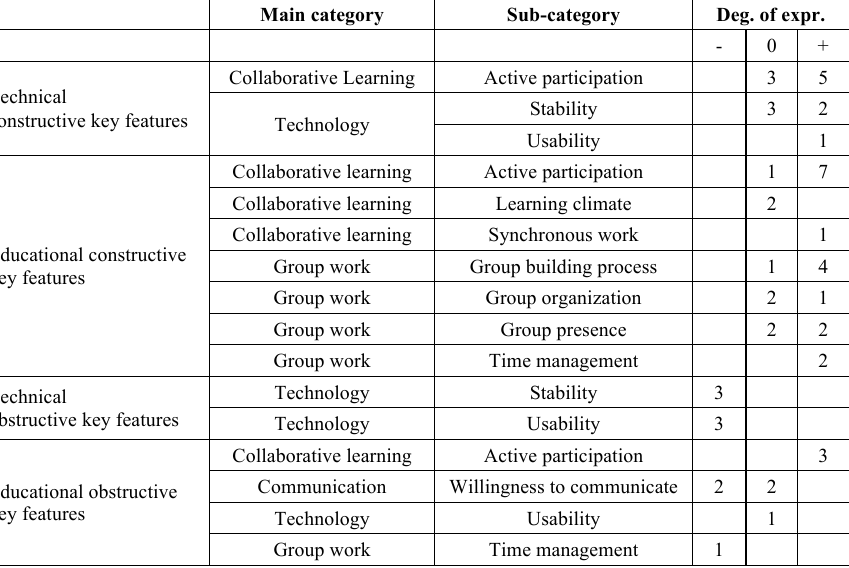
Table 7. Qualitative analysis Course